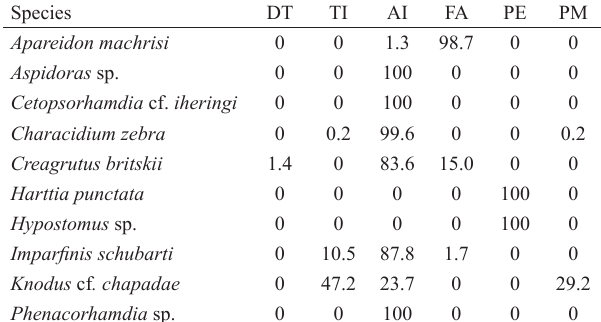
Table 2. Alimentary Index values for the species analyzed. DT - Detritus; TI - Terrestrial Invertebrates; AI - Aquatic Invertebrates ; FA- Filamentous Algae ; PE - Periphyton; PM - Plant Material.